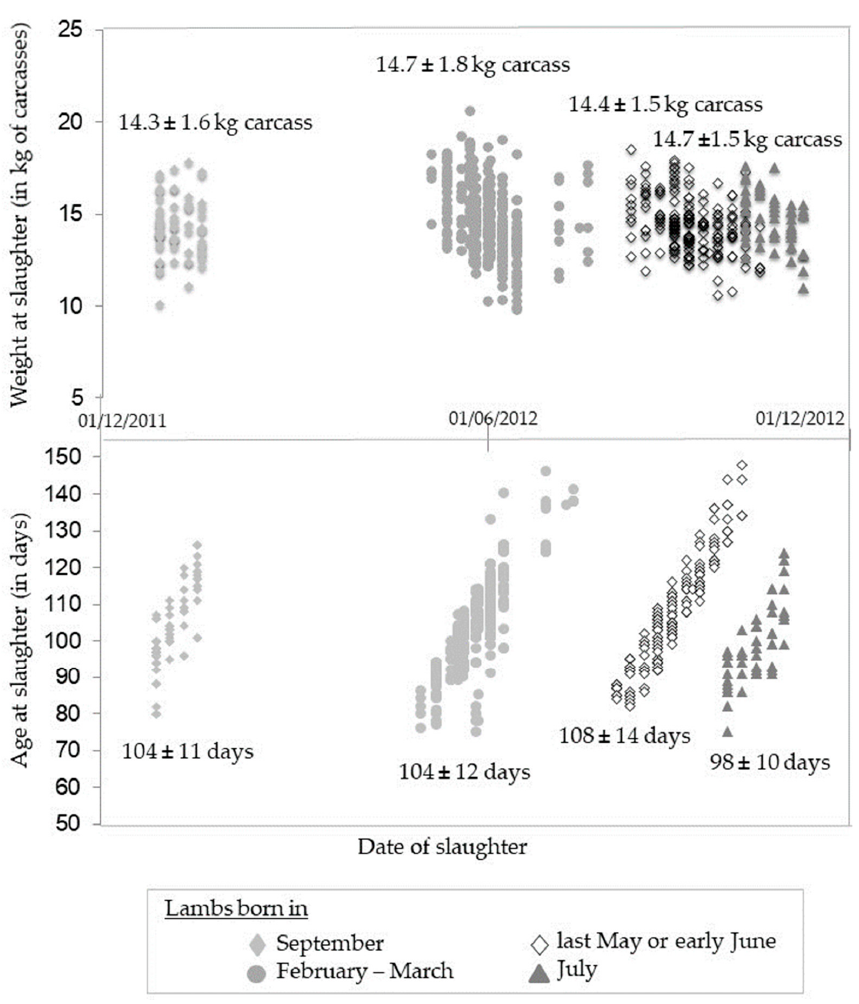
Figure 1. Example of sheep meat Farmer 5 who spreads out the sales to reduce